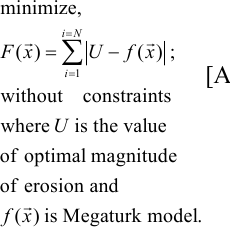
Fig. 10. 3D surfactal simulation results for Table V and Eq. (3) model. The impact velocity is 40 m/s. Range of angles for Eq. 3 is [70°; 85°]. Range of hardness is [1600; 2500]. Results corroborate the Tables VI, VII numbers. Thus, a global minimum is not totally well-defined. Matrices of imaging are 75 × 75.